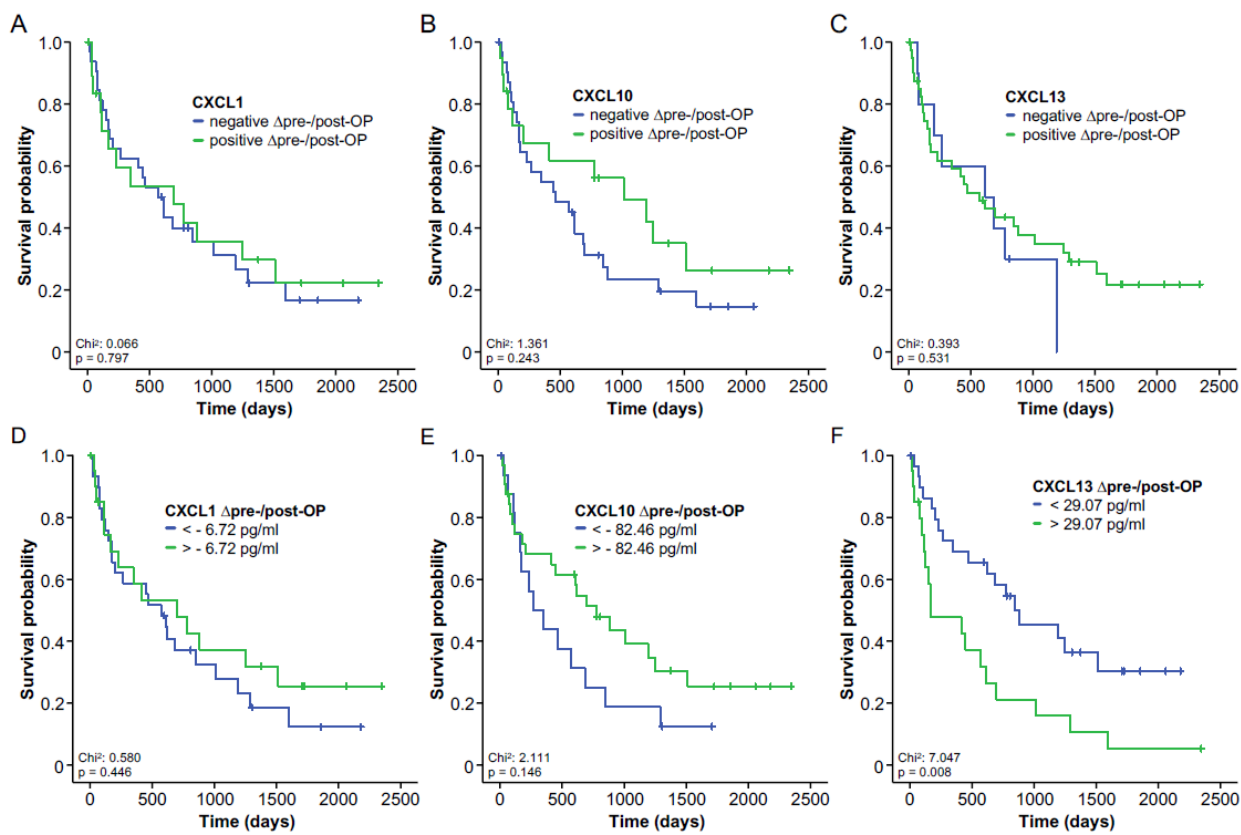
Figure 4. Longitudinal course of circulating chemokine levels. ( A – C ) Overall survival in patients with increasing or decreasing CXCL1, CXCL10 and CXCL13 levels. ( D – F ) Overall survival in patients with increasing or decreasing CXCL1, CXCL10 and CXCL13 levels using ideal prognostic cut- off values.